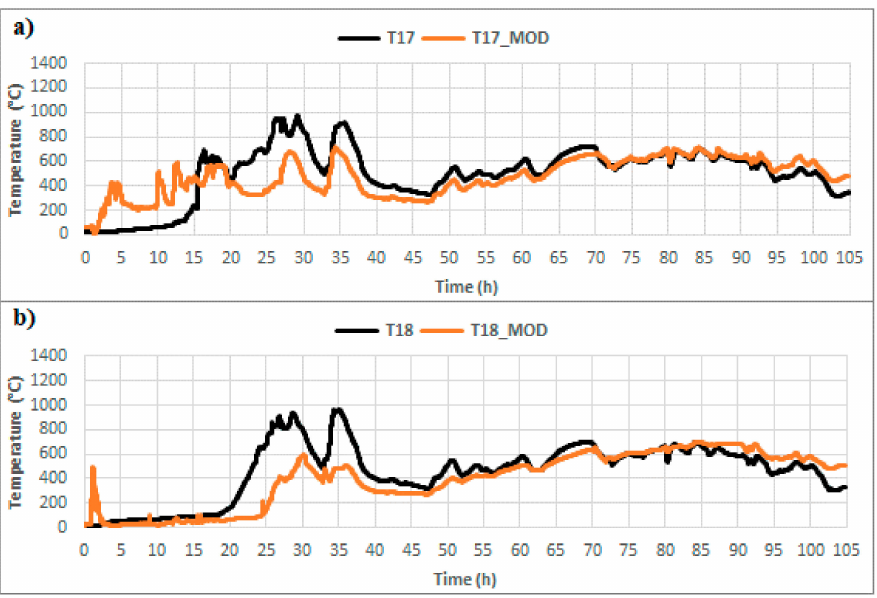
Figure 23. The measured (T) and modeled (T_MOD) temperature behavior in the second phase verification by using modified regression models, ( a ) temperature T 17 , ( b ) temperature T 18 (Source: own